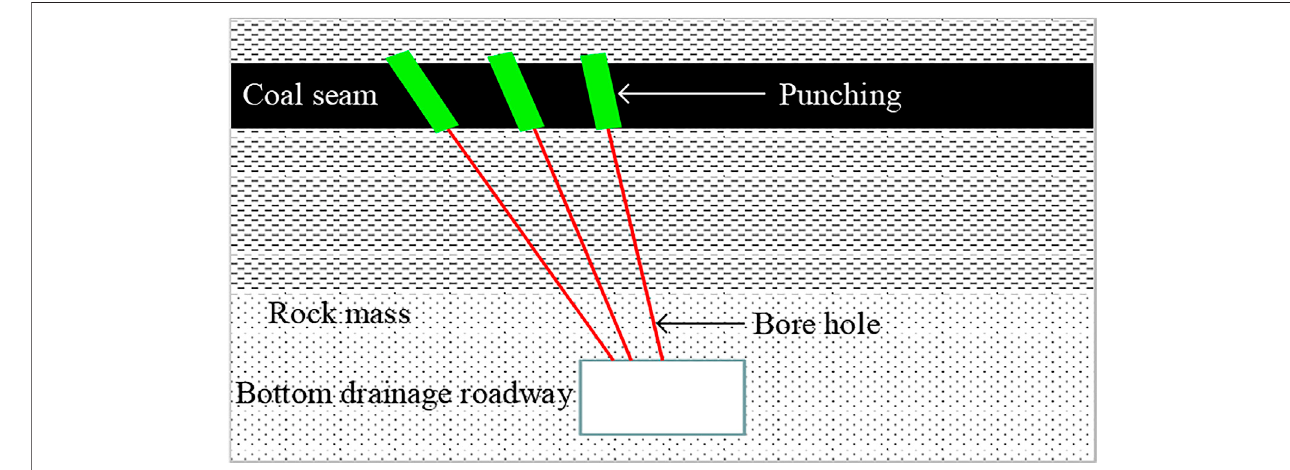
FIGURE 1 | Pro fi le map of